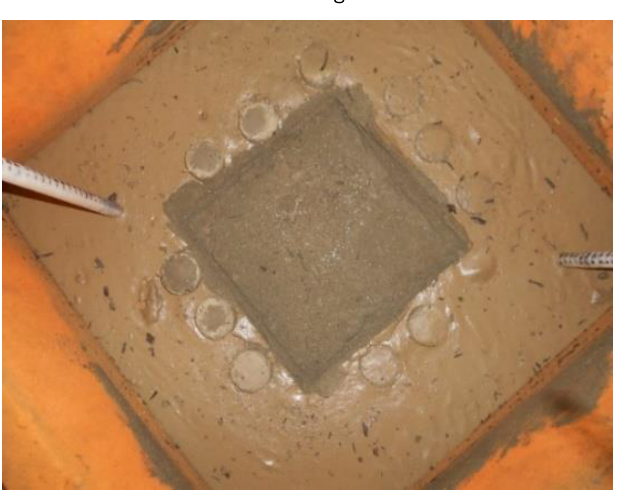
Fig. 10. Penetration of structure inside the soil was negligible after shaking